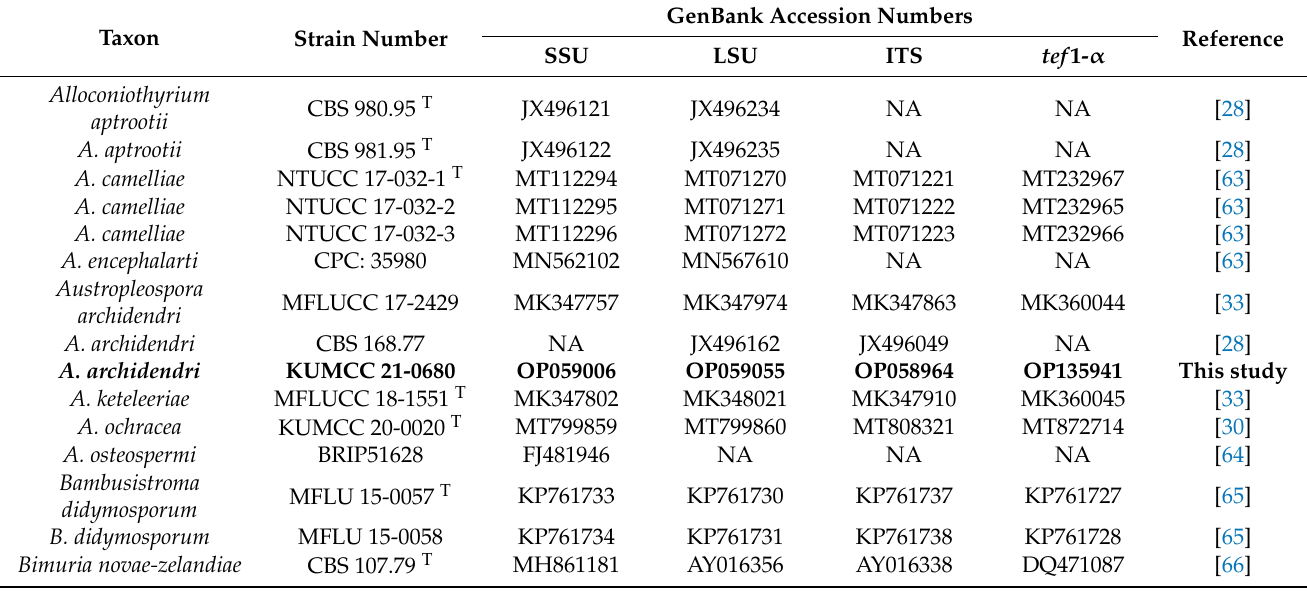
Table 1. Taxa used in the phylogenetic analysis, species voucher/culture numbers, and GenBank accession numbers for the